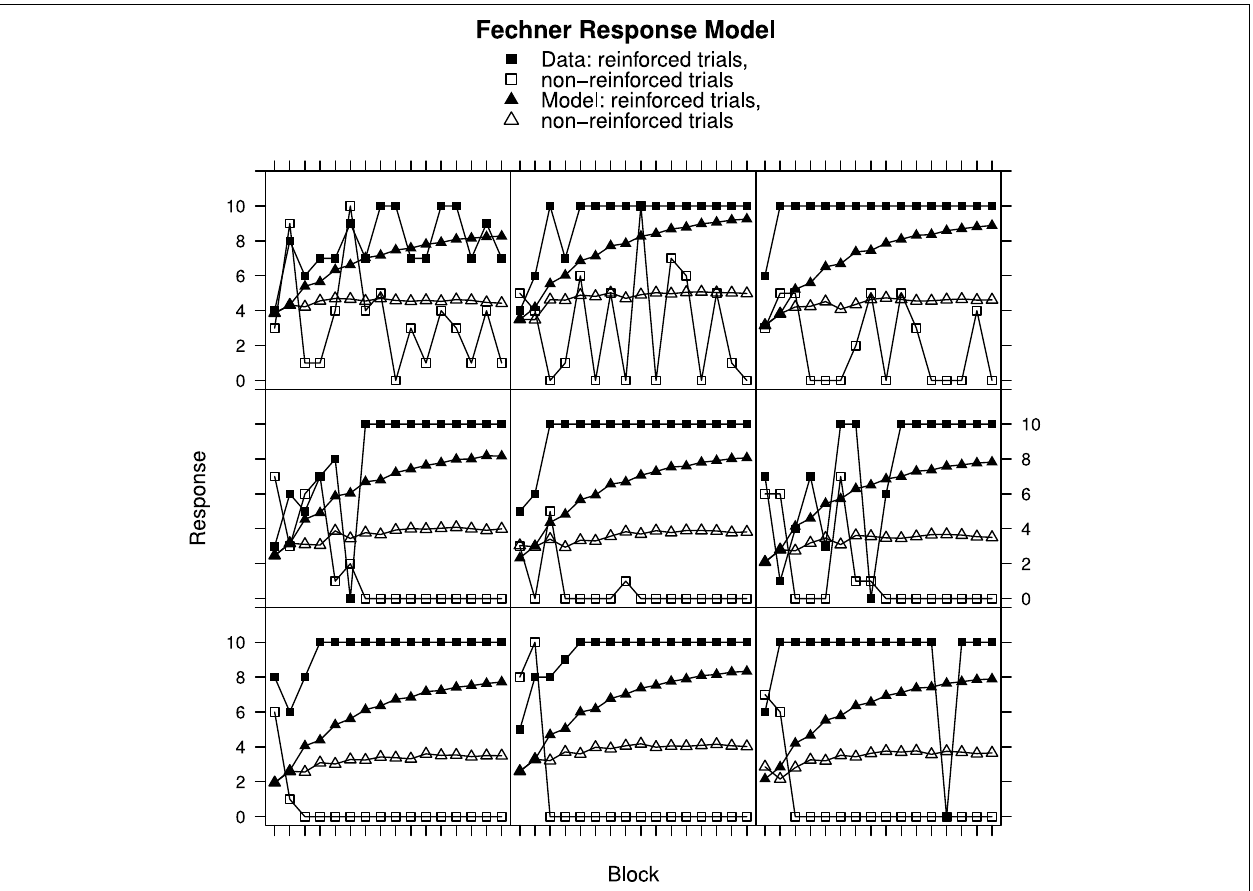
FIGURE 2 | RatingsandRescorla–WagnerModelpredictionsforreinforcedandnon-reinforcedtrialsusingtheFechnerResponseModelinExperiment1. Top row , best fitting model samples. Middle row , intermediate fits. Bottom row , worst fitting model samples. See Results section on page 8 for further details.